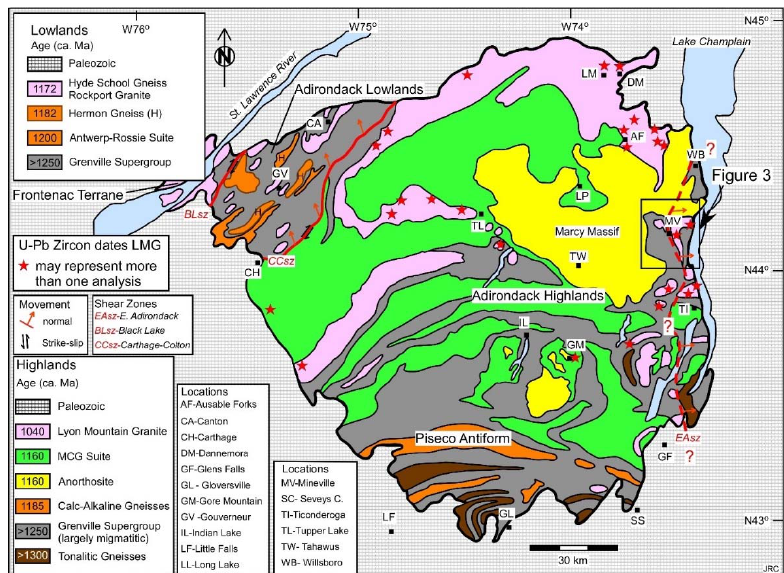
Figure 2. A generalized geological map of the Adirondack region. Colored units consist of igneous rocks dated by U-Pb zircon geochronology with ages indicated in the legend. The grey unit is metasedimentary rocks of the Grenville Supergroup deposited between 1250–1300 Ma. Separate legends are given for the Highlands and Lowlands terranes. Small red stars note sampling locations for U-Pb zircon analyses of the Lyon Mountain Granite (LMG)